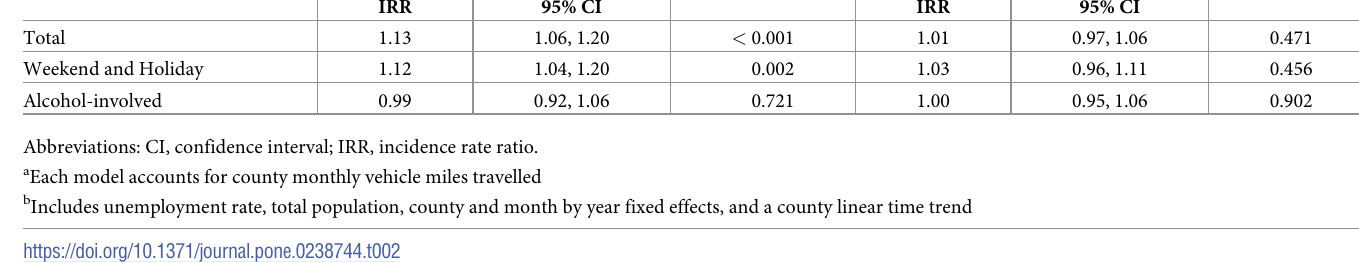
Table 2. Incidence rate ratios for the association of uber availability and total, weekend- and holiday-specific, and alcohol–involved related traffic fatalities, princi- pal counties of the largest 100 US metropolitan areas, 2009–2017 a . Traffic